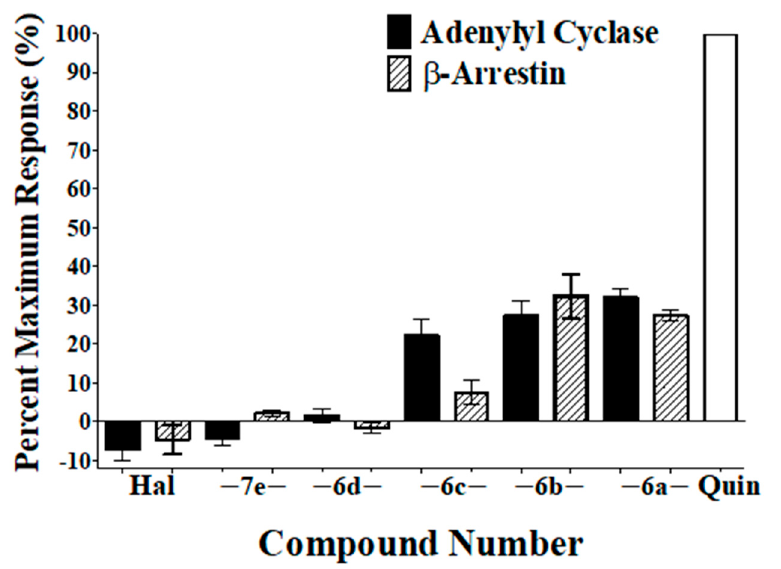
Figure 3. Comparison of the Efficacy of Phenylthiophene Analogs for Adenylyl Cyclase Inhibition and β -Arrestin Binding at Human D3 Dopamine Receptors . A comparison of the efficacy of com- pounds 6a – d and 7e for the inhibition of adenylyl cyclase and the binding of β -arrestin is shown. Values were normalized to reference full agonist quinpirole (10,000 nM). The concentration of the test compound was equal to 10× the K i value as determined from competitive radioligand binding studies, therefore 90% of the binding sites were occupied.